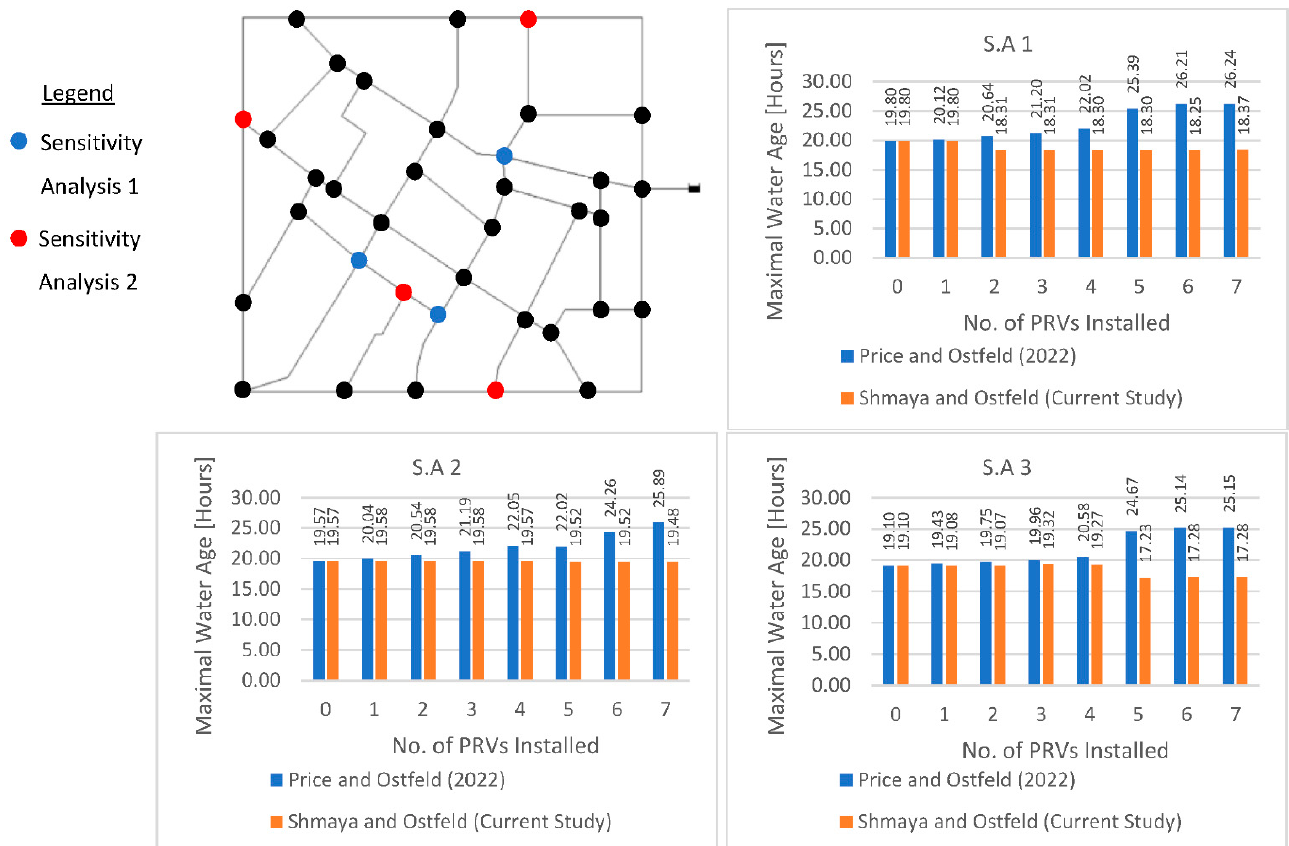
Figure 9. Sensitivity analysis results for the Fossolo network. The modifications are shown in ( top left ). The results for scenario one are shown in ( top right ), for scenario two in ( bottom left ) and for scenario three in ( bottom right ).